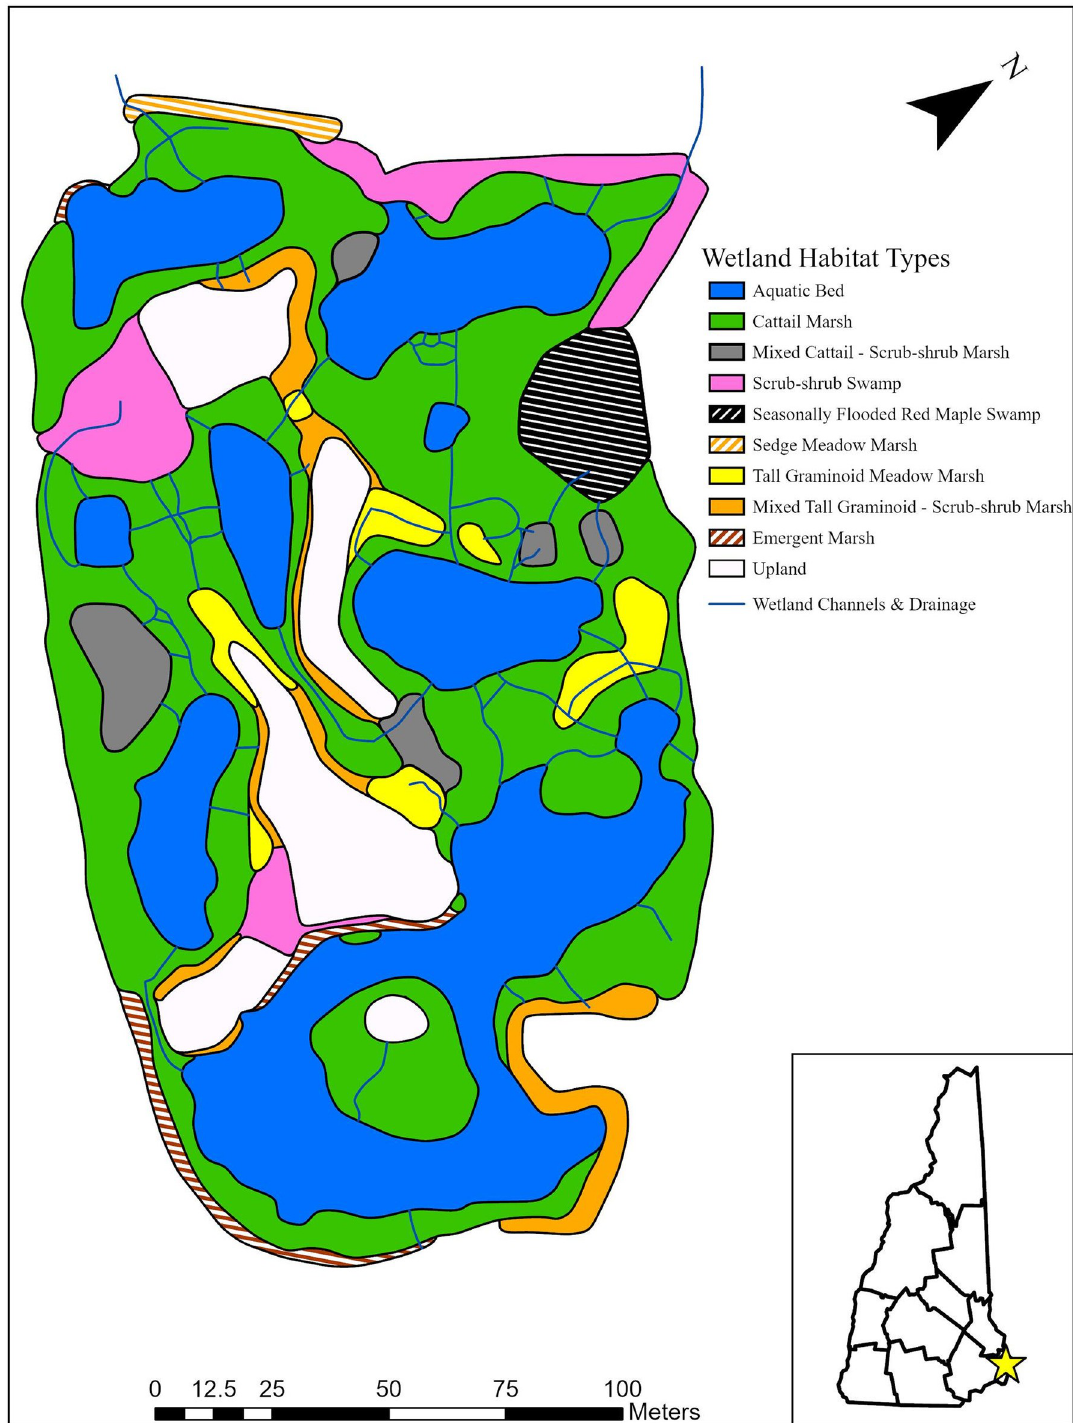
Fig 3. Wetland community distribution map of Quarry Pond in 2020 based on plot sampling and drone imagery. Wetland community types were classified based on plot sampling of ground cover, shrub, and tree canopy. Areas and wetland channels were manually digitized using drone imagery in ArcGIS